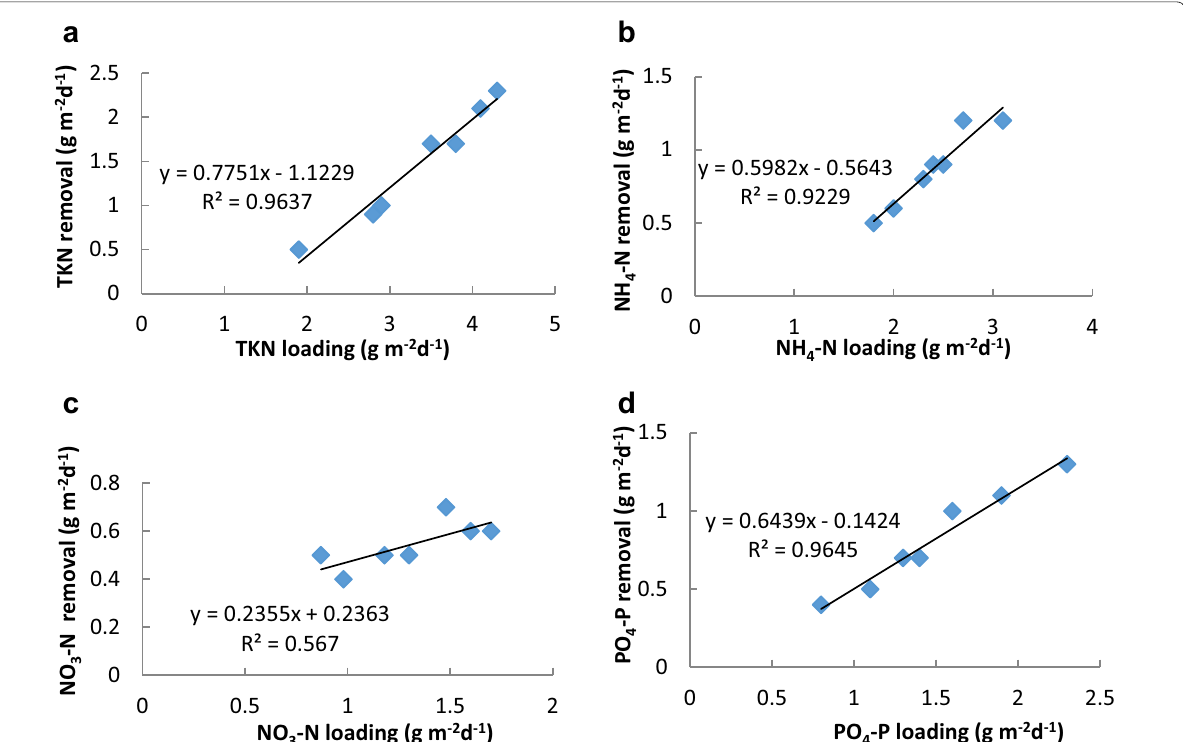
Fig. 2 Removal of nutrients during system operation. a TKN mass loading vs. mass removal; b NH 4 + -N mass loading vs. mass removal; c NO 3 − -N mass loading vs. mass removal; d PO 4 − 3 -P mass loading vs. mass